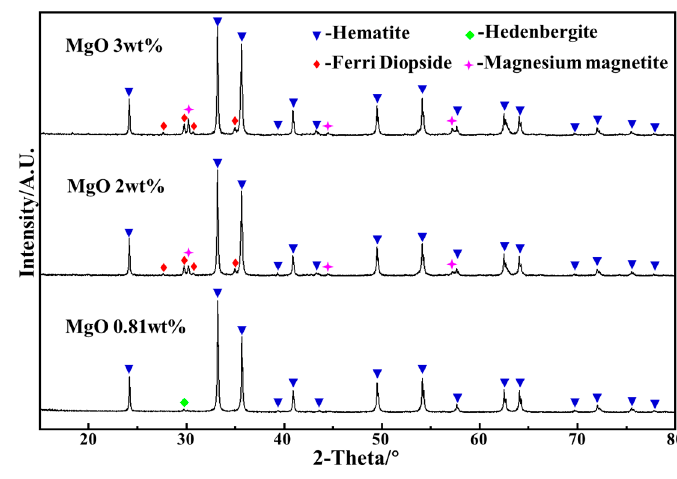
Figure 5. X ‐ ray diffraction (XRD) patterns of deposit simulants. Figure 5. X-ray diffraction (XRD) patterns of deposit